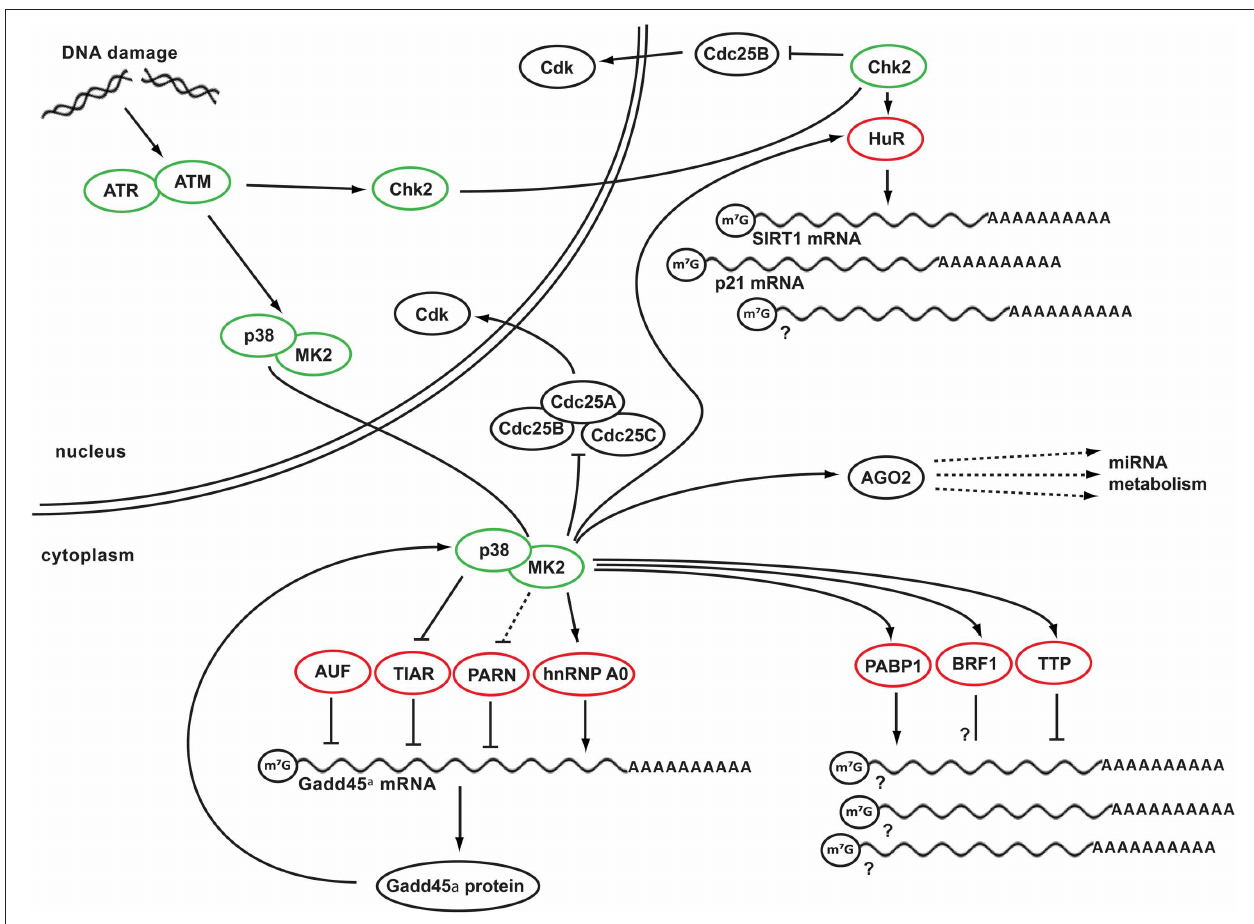
FIGURE 1 | DDR kinase signaling at the crossroads of cell cycle arrest and posttranscriptional control of RNA stability. Depicted is a simplified schematic network integrating key DDR kinases and RNA-binding proteins. In response to genotoxic stress, ATM activates its effector kinase Chk2 and the p38MAPK/MK2 kinase complex. Chk2 in turn phosphorylates HuR, promoting its binding to SIRT1 mRNA. Binding of HuR to additional client mRNAs, such as p21 mRNA appears to be regulated by MK2, which also mediates RNA binding of several other RBPs, including PABP1, BRF1, and TTP. In addition, MK2 phosphorylates hnRNP A0, promoting its binding to and stabilization of Gadd45 α mRNA. In the absence of DNA damage, Gadd45 α